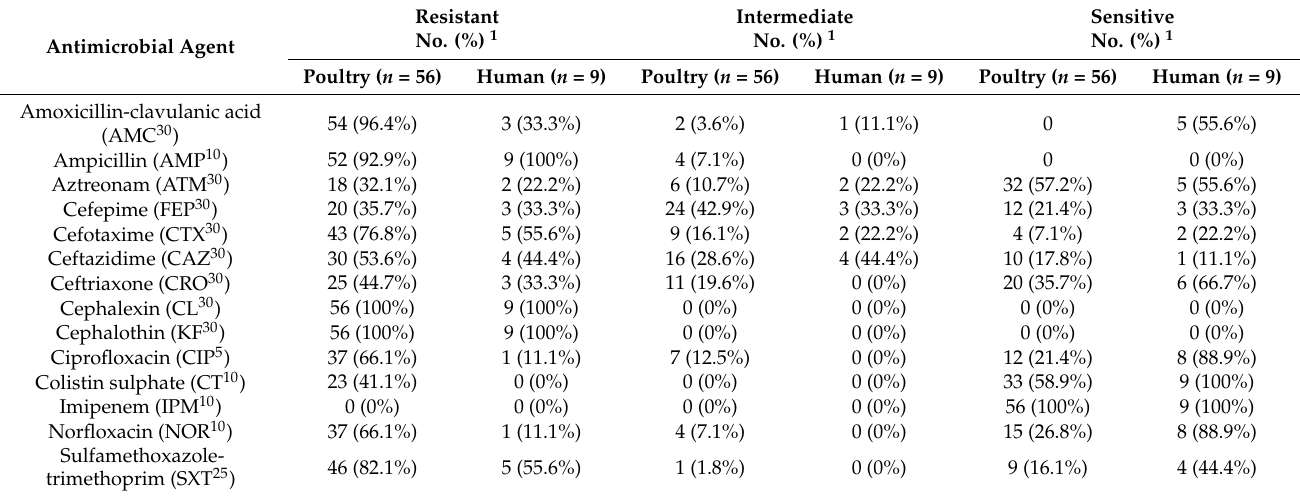
Table 2. Antimicrobial susceptibility pattern of the isolated E. coli from poultry and human.